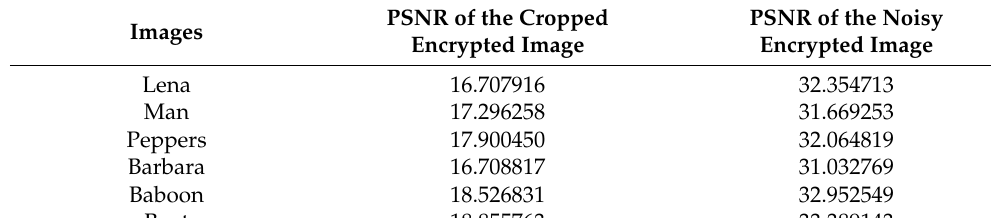
Table 5. PSNR values of the cropped encrypted images.